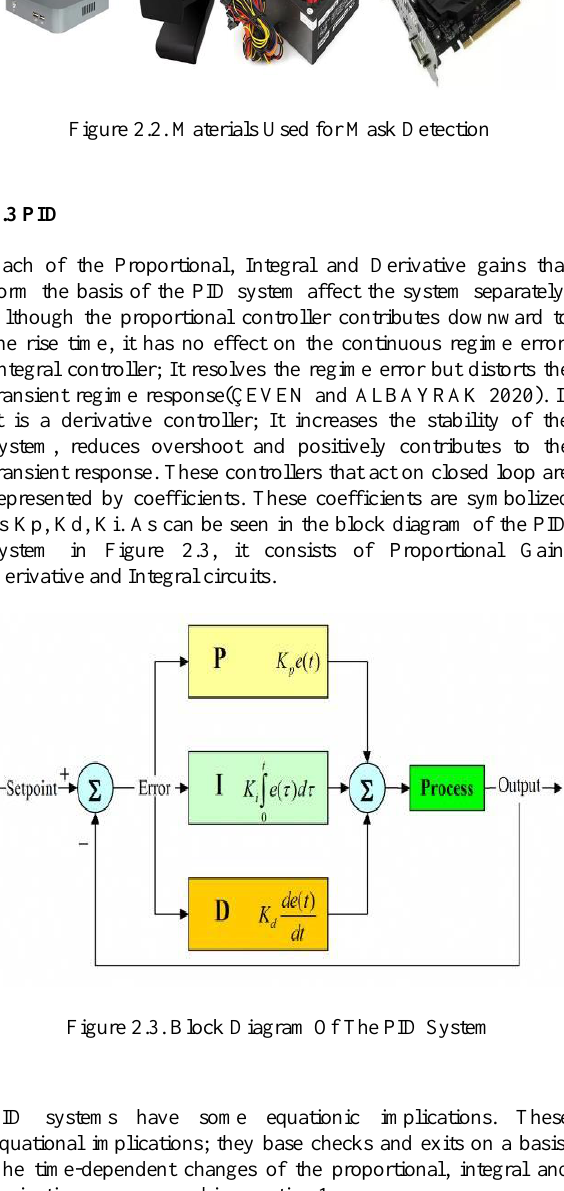
PID systems have some equationic implications. These equational implications; they base checks and exits on a basis. The time-dependent changes of the proportional, integral